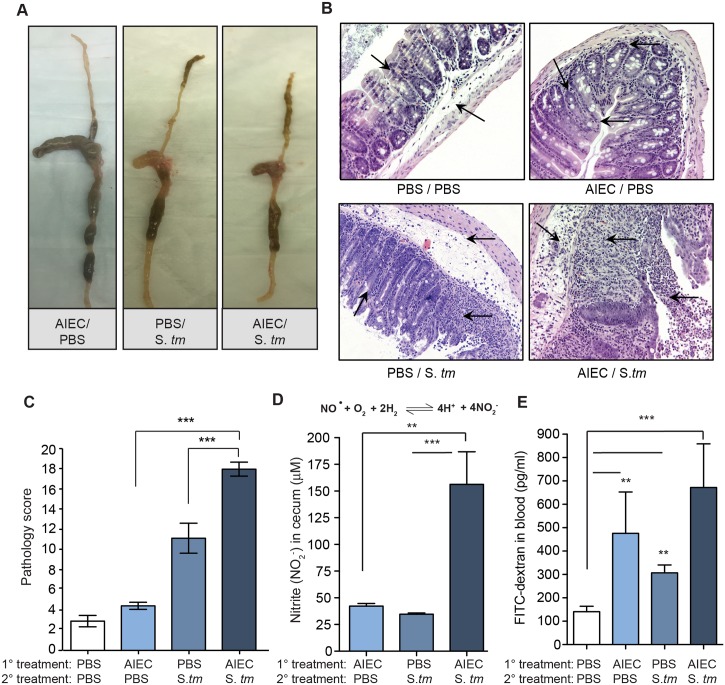
Prior AIEC colonization worsens pathology following S. Typhimurium infection.(A) Gross pathology in the small and large intestine of 129e mice 5 days after Salmonella infection. (B) H&E-stained cecal sections from 4 experimental groups of 129e mice (as indicated). Images are representative of 5 mice per group from 4 independent experiments. Arrows indicate submucosa edema, desquamation, epithelial sloughing, crypt hyperplasia, and inflammatory cellular infiltrates in the lumen and mucosa. Original magnification 40x. (C) Cecal pathology was scored from H&E stained sections taken from day 5. Data are the mean with ± SEM for 5 views per mouse and 5 mice per group. ***p<0.001 (Mann-Whitney). (D) Nitrite concentration in cecal samples on day 5 after Salmonella infection. Treatment groups are indicated. Data are the means with SEM. **p<0.01, ***p<0.001 (Mann-Whitney). (E) FITC-dextran concentration in the serum following oral gavage in the indicated groups. Data are the means with SEM. **p<0.01, ***p<0.001 (Mann-Whitney).